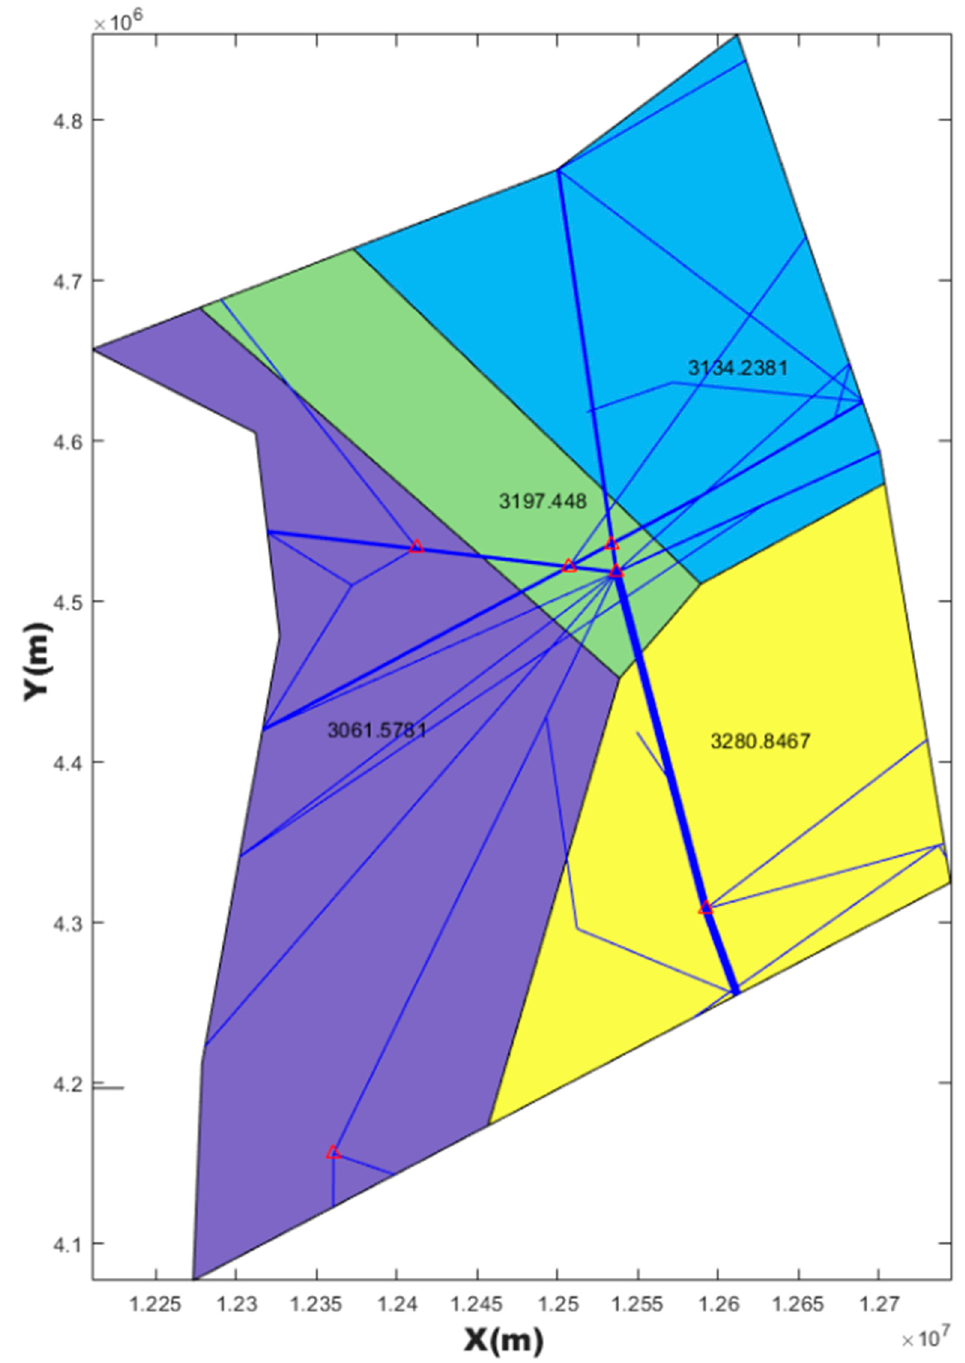
Figure 18. Post-processing results of Figure 14 with MC-CLFV.